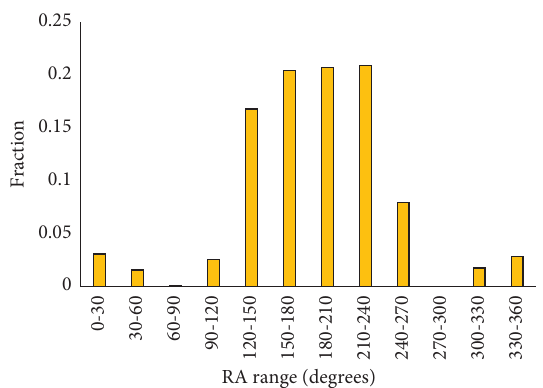
Figure 1: Te distribution of the galaxies in the dataset in diferent parts of the sky. Te y -axis shows the fraction of the galaxies in each 30 degrees RA range out of the total number of galaxies in the